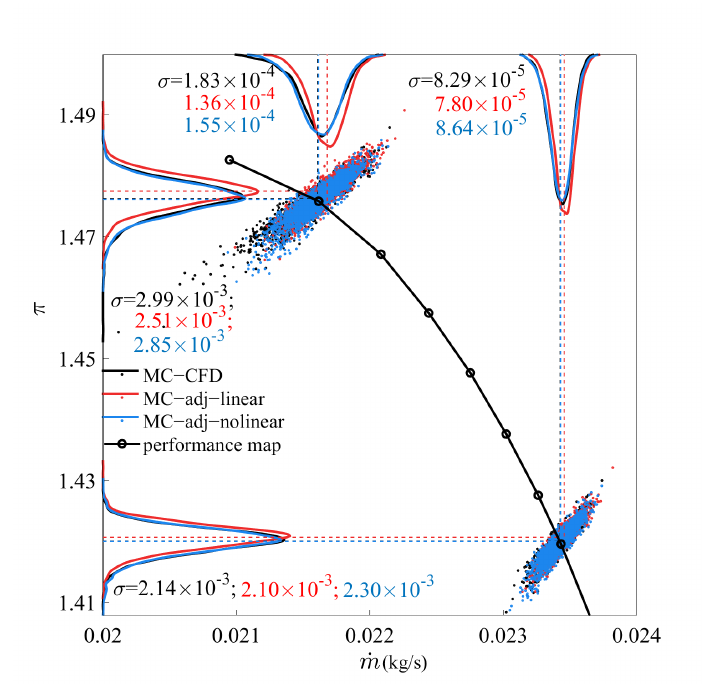
Figure 9. Performance characteristic with PDFs of mass flow rate and pressure ratio using the three methods.